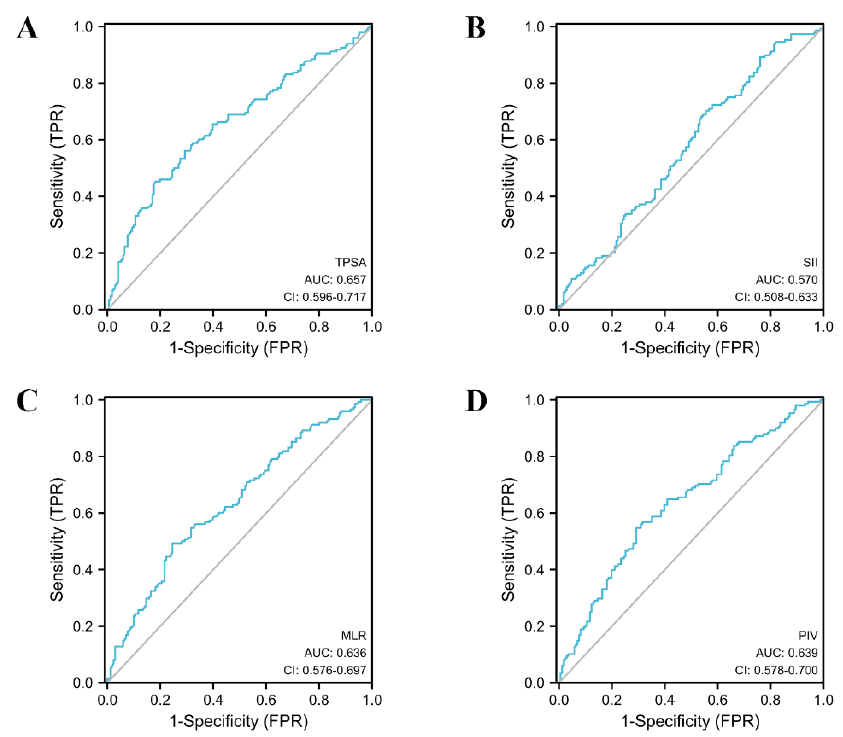
Figure 2. The AUC curves of TPSA and inflammatory markers in prostate cancer. ( A ): The AUC curves of TPSA; ( B ): The AUC curves of SII; ( C ): The AUC curves of MLR; ( D ): The AUC curves of PIV.